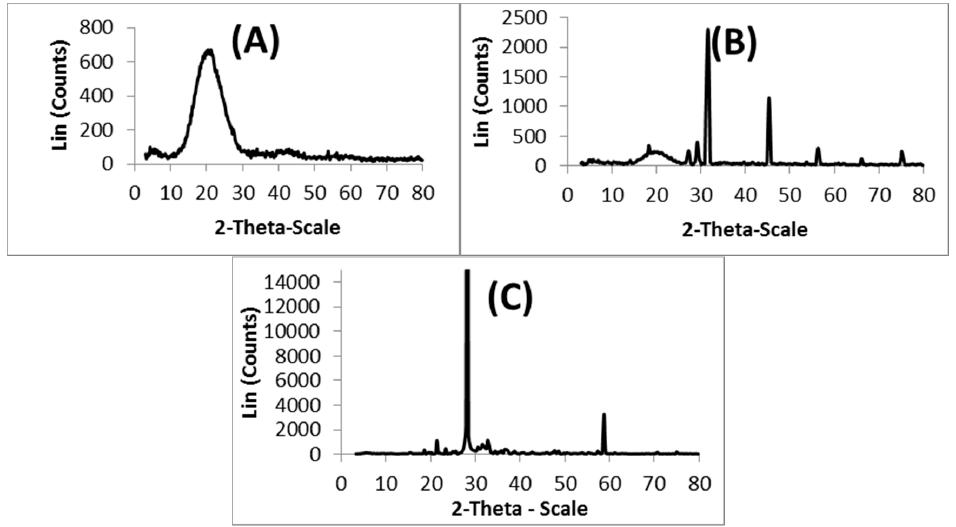
Figure 3. XRD patterns of ( A ) placebo blend hydrogel microspheres; ( B ) 5-FU-loaded blend hydrogel microspheres, and ( C )